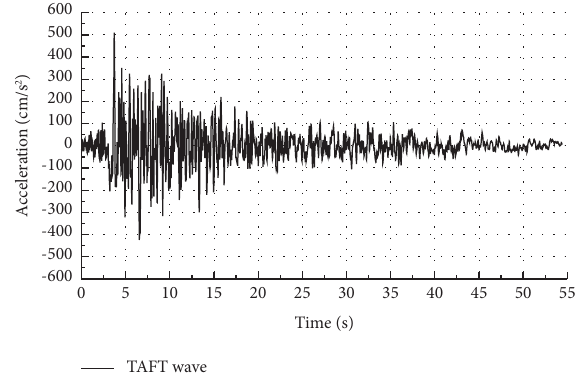
Figure 7: Time-history curve of Taft waves.